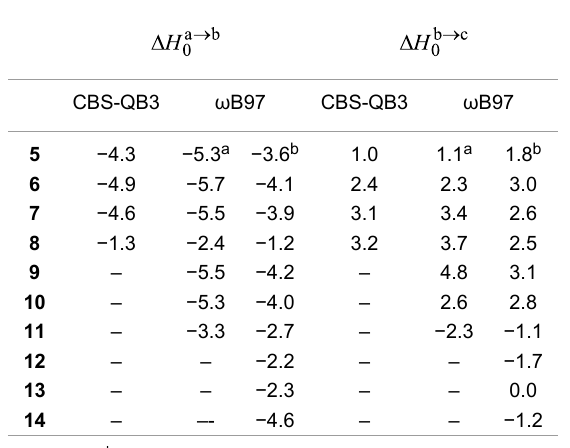
Table 2: Isomerization energies for the amides/carbamates outlined in Figure